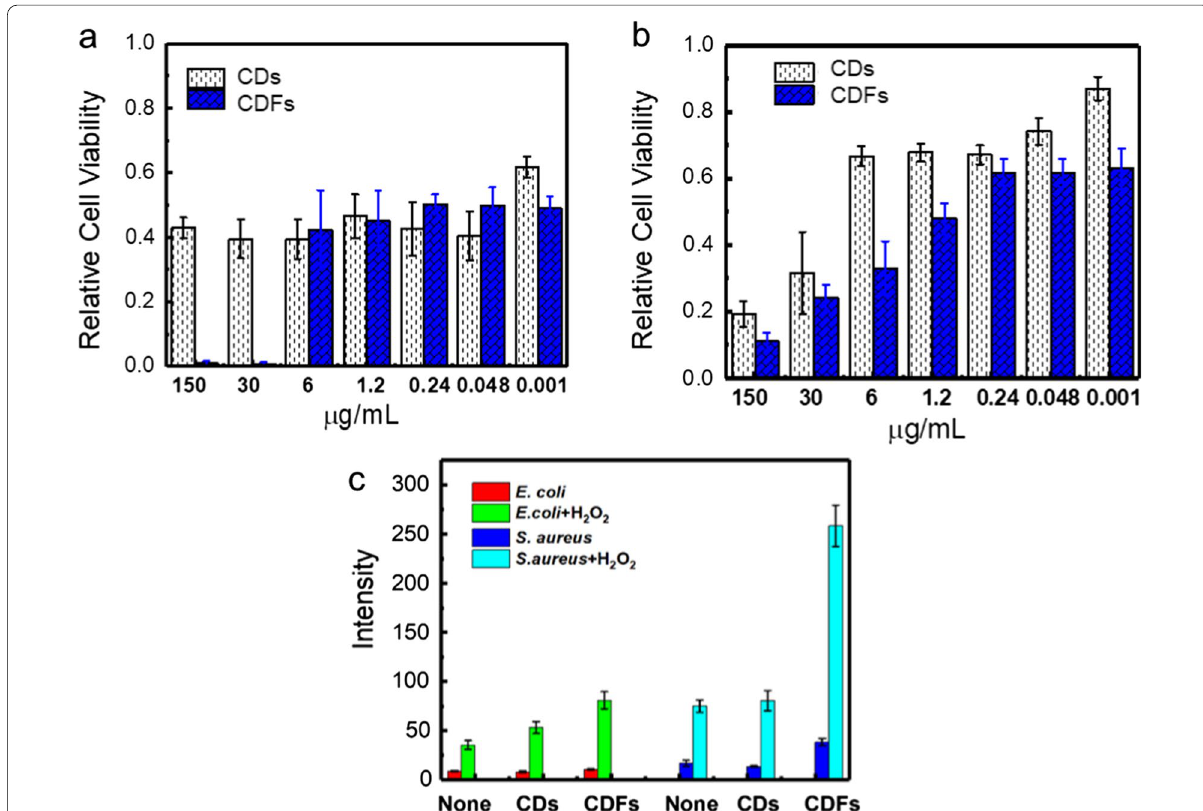
Fig. 6 Antibacterial activity of CDs and CDFs against S. aureus ( a ) and E.coli ( b ), c fluorescence intensity of DCF at 525 nm, which shows a linear relationship with the ROS level, with the treatment of CDs and CDFs in the absence and presence of H 2 O 2 (100